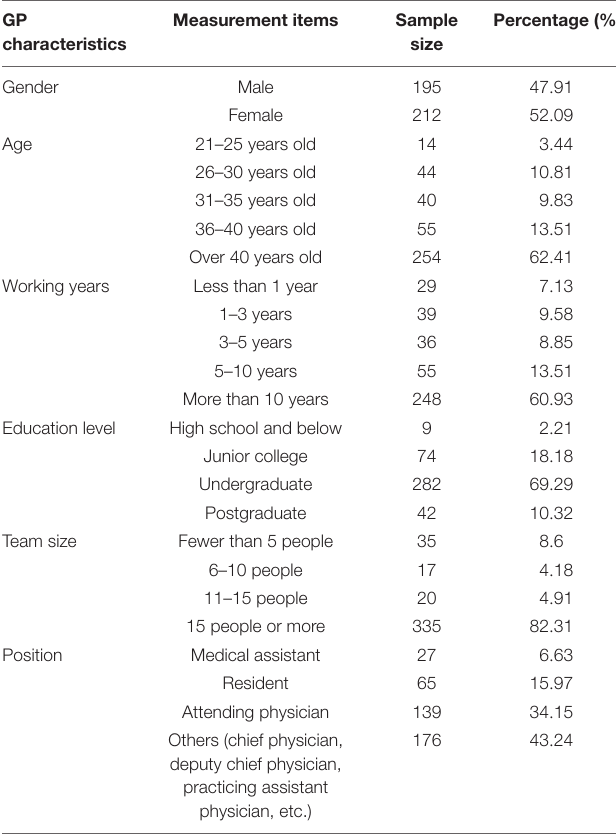
TABLE 1 | Basic characteristics of the research